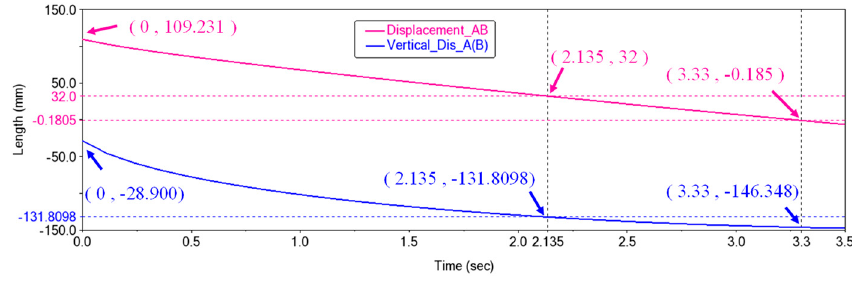
Figure 13. Displacement of AB and the distance of the vertical motion.